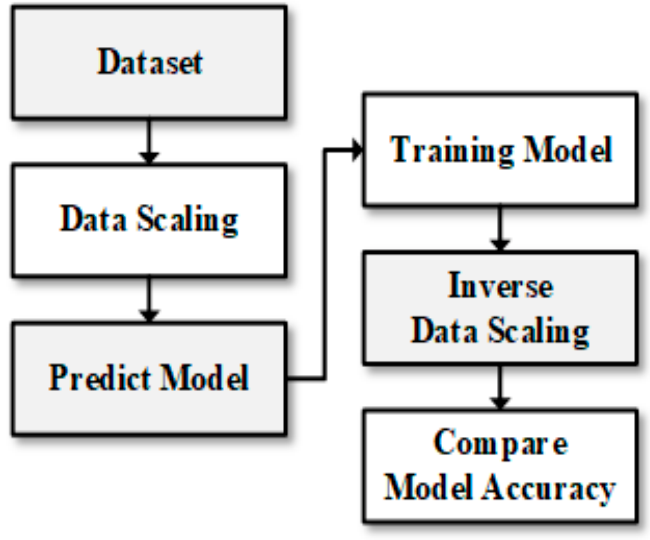
Figure 7. Learning Figure 7. Learning procedure. Figure 7. Learning procedure.